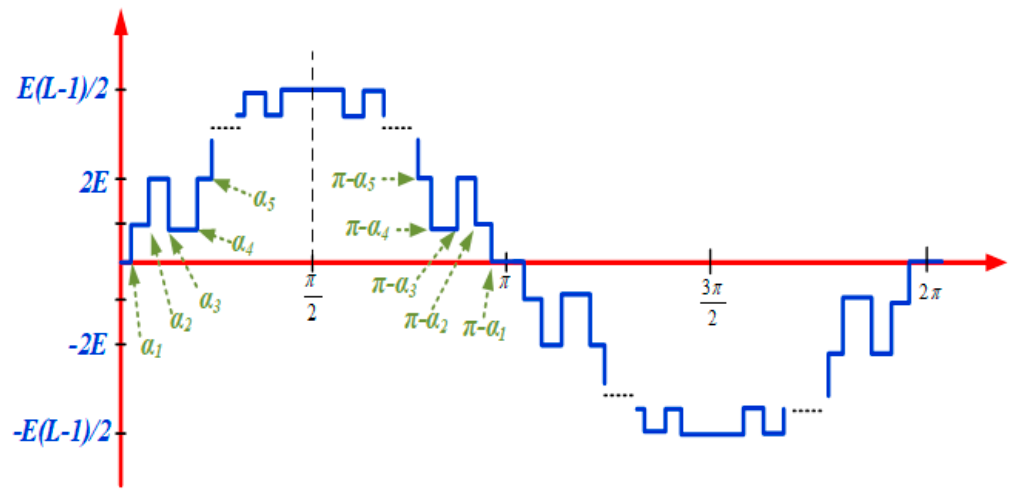
Figure 2. Generalized quarter wave symmetrical L ‐ level output voltage waveform.